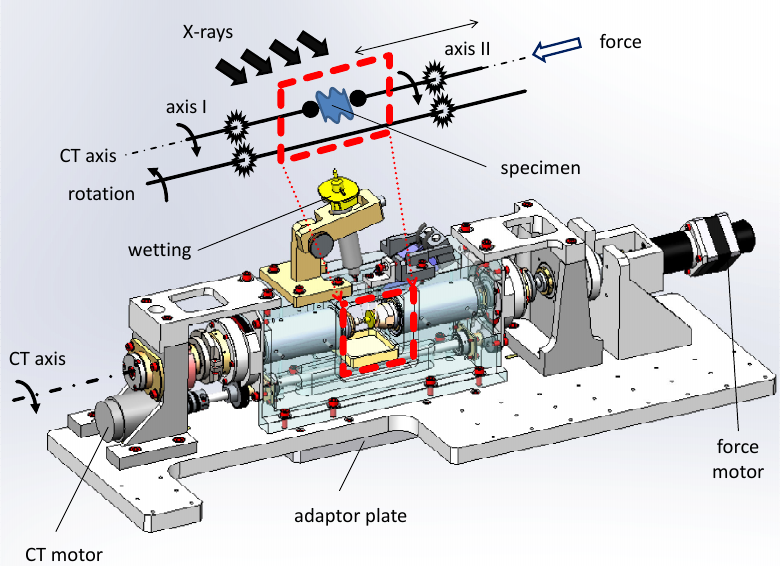
Figure 1. Open view sketch of the basic design of the TomoPress (cf. also Figure 2). The inset illustrates the principle idea—a single axis acts as master for the tomographic rotation. It is connected via precise gear wheels to the two axes which clamp and rotate the sample. One of them (“axis II”) is mounted in a gliding manner to allow for application of the external force while “axis I” is fixed during acquisition but can be released for sample mounting. An adaptor plate is used to mount the press onto standard alignment